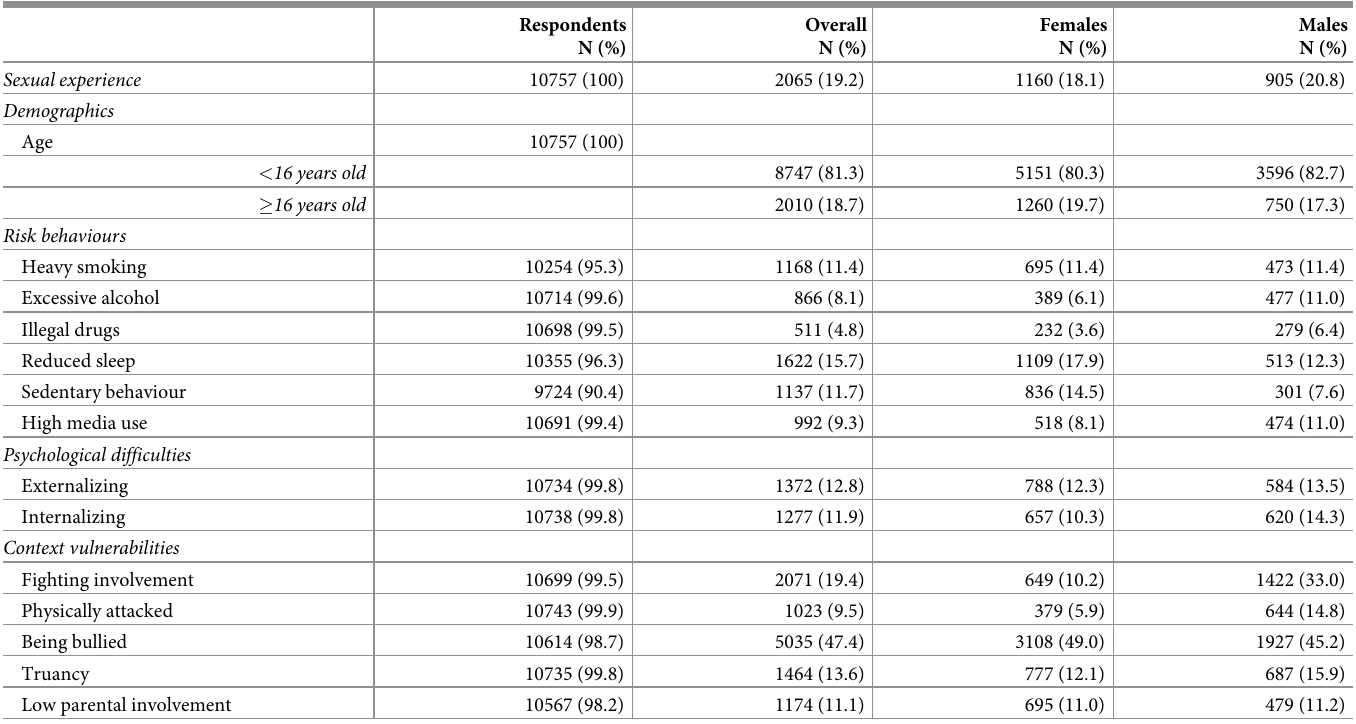
Table 1. Baseline characteristics of the study